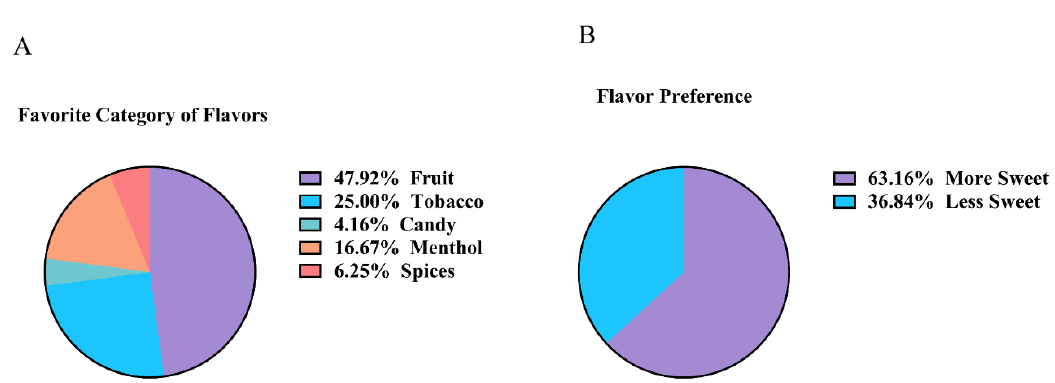
Figure 1. Flavor preferences of subjects. ( A ) Self-reported survey data based on favorite flavor. Total number of subjects = 48. ( B ) Self-reported survey data based on sweetness of flavor. Total number of subjects = 38.